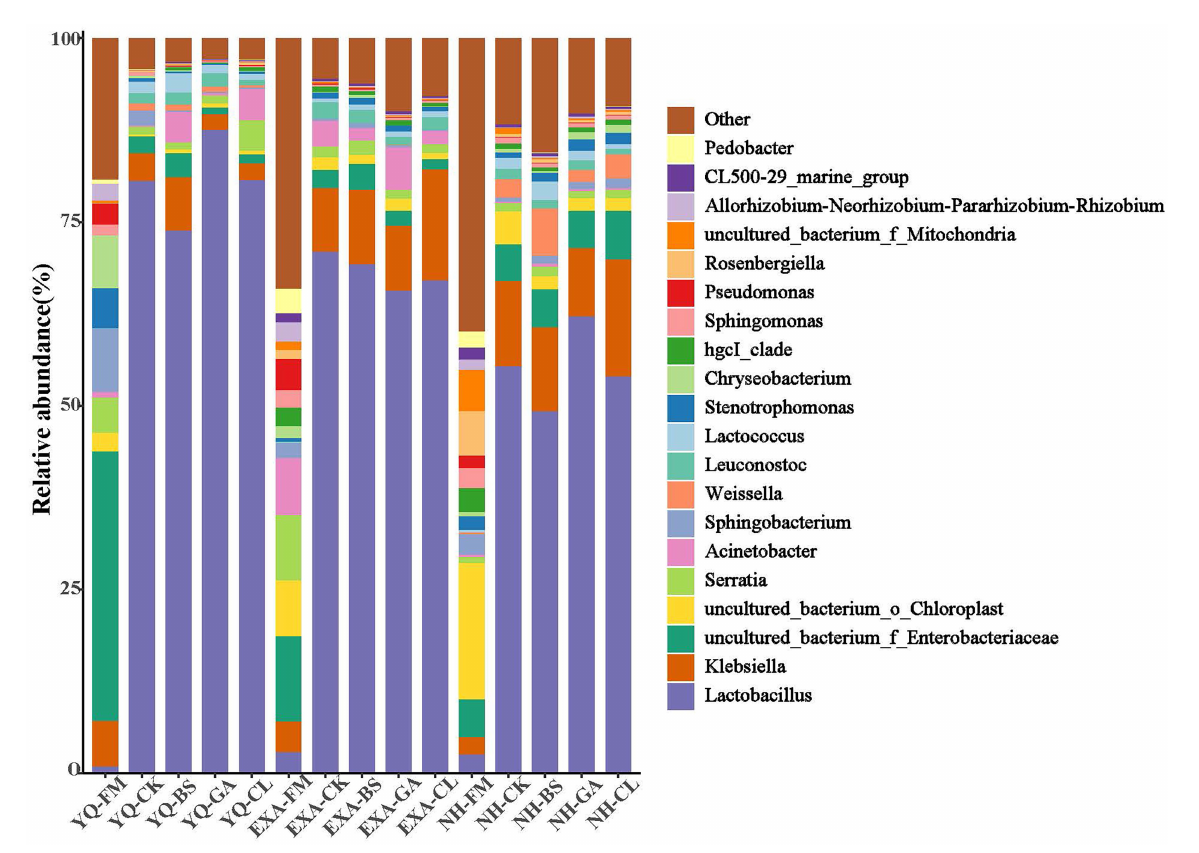
FIGURE 4 Relative abundance of bacterial communities at the genus levels for whole-plant corn silage with different treatments. YQ, corn variety Yuqing 386; EXA, corn variety Enxiai 298; NH, corn variety Nonghe35; FM, fresh raw materials; CK, no additives; BS, 0.02% Bacillus subtilis CP7 of FM; GA, 0.2% gallic acid of FM; CL, 0.02% cellulase of